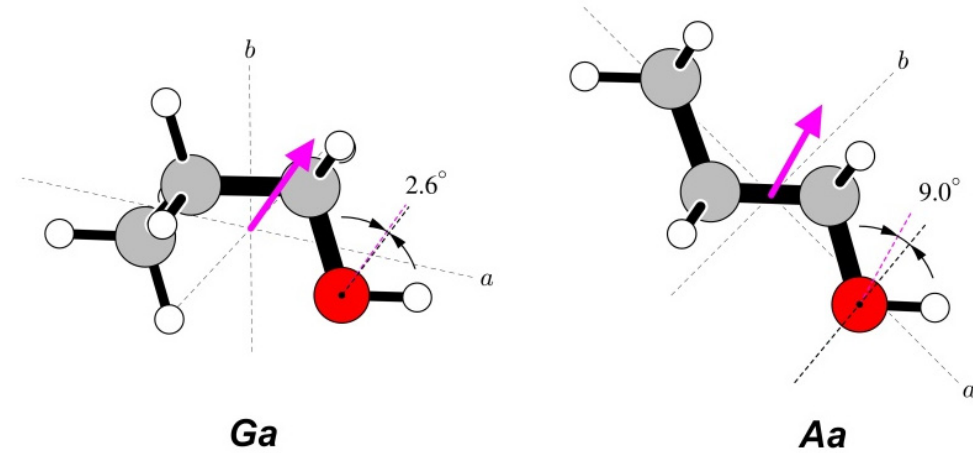
Figure 4. Orientations of the measured dipole moments in the two studied conformers of n -propanol. The dipole moment arrows are drawn from the centres of mass and are in the direction from the notional negative to the notional positive charge. Both molecules have been rotated such that the COH segments are oriented in a similar way in the plane of the paper. Dipole moment directions are compared at the oxygen atoms with orientations of the ∠ COH bisectors. There is a rather close correspondence between these directions for the most stable Ga conformer, while for the Aa conformer, there is a significant distortion of the positive dipole moment direction towards the aliphatic group.